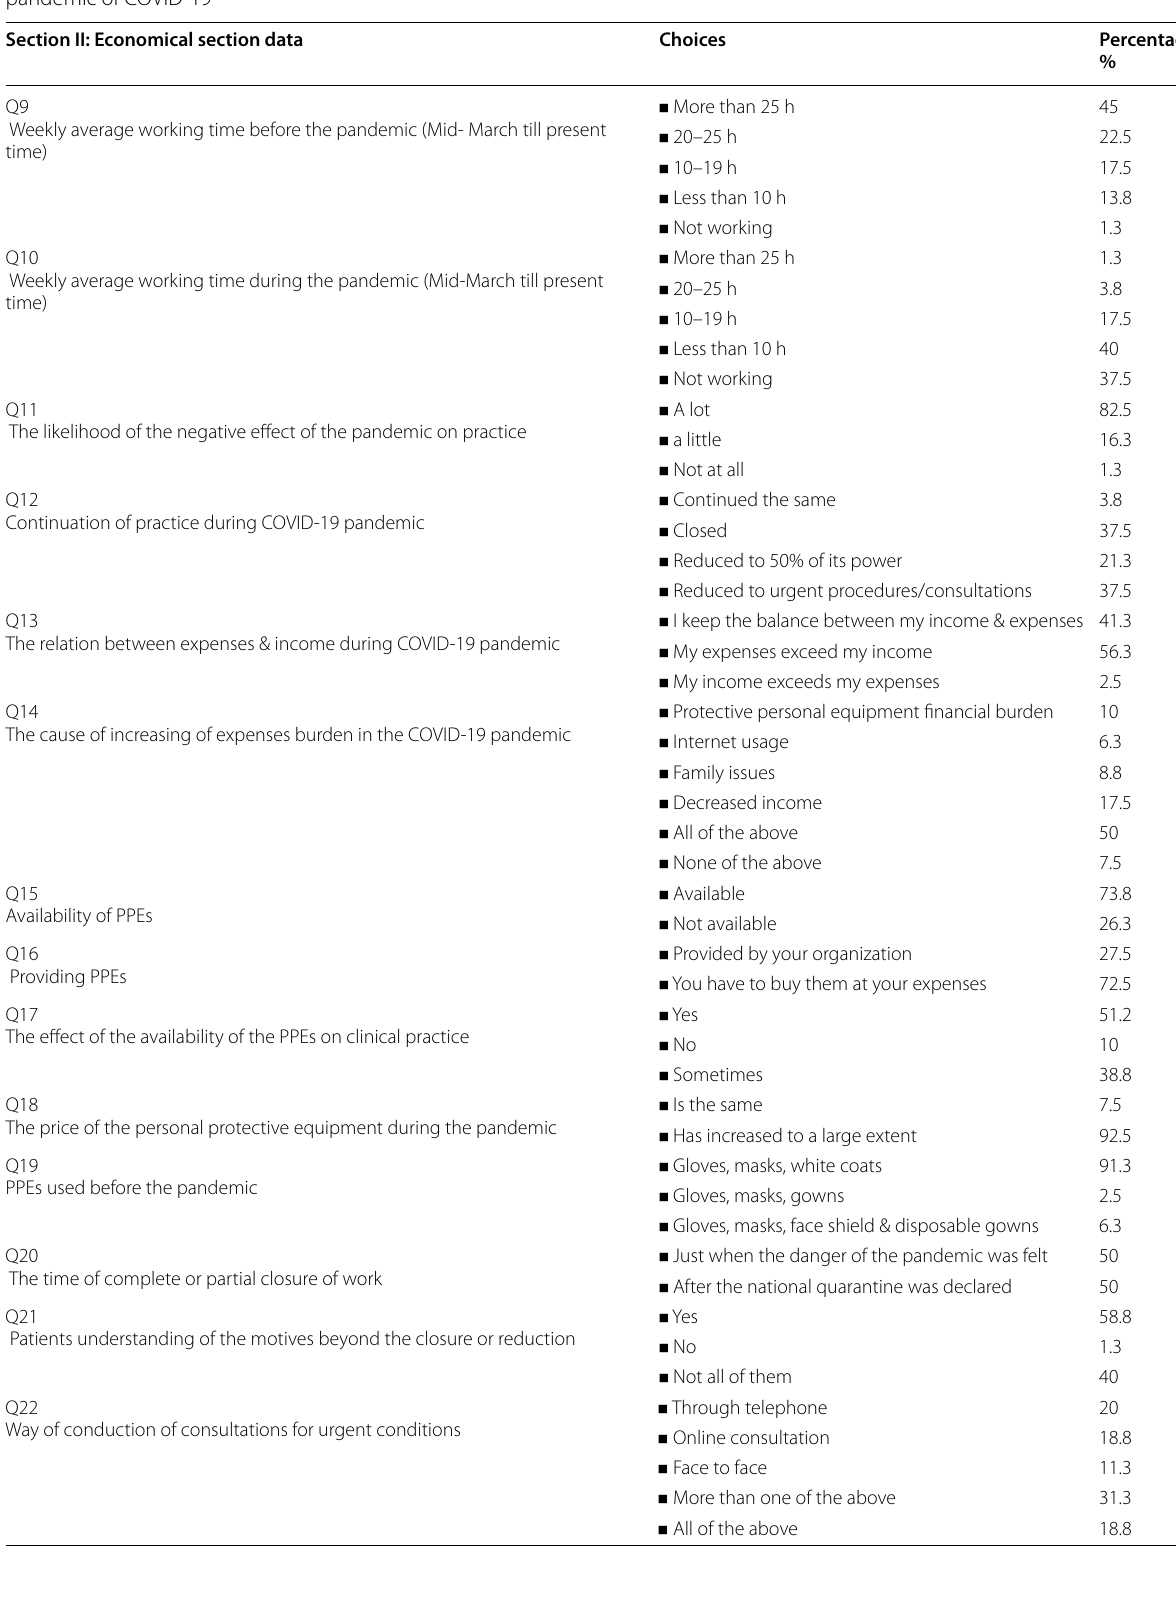
Table 2 The percentages of the collected data about the economical aspect of the studied group of phoniatricians during the pandemic of